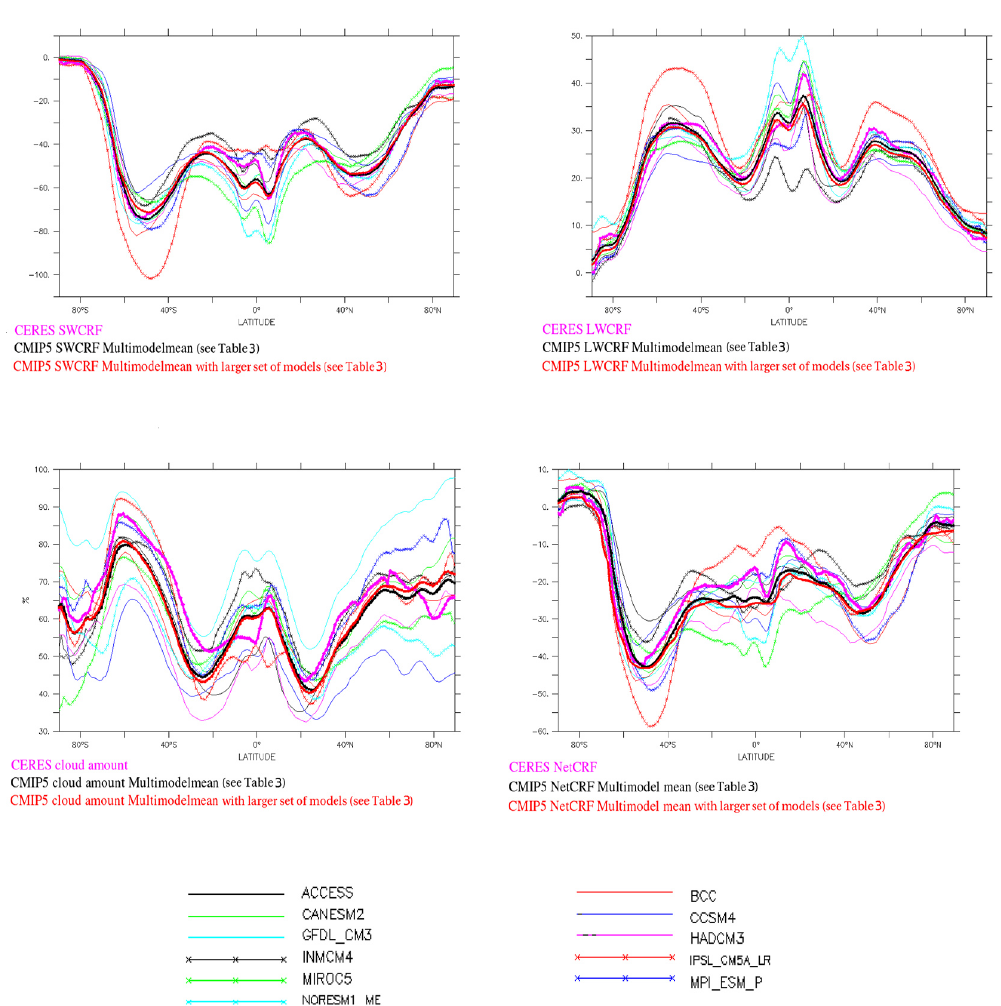
Figure 1. SWCRF and LWCRF (upper left and upper right) given in Wm − 2 , cloud amount (lower left) given in percent and NetCRF (lower right) given in Wm − 2 for the models listed in Table 4 together with CERES data and the multi-model zonal mean for 10